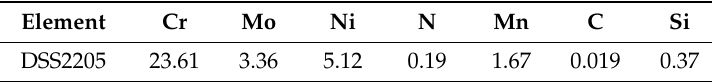
Table 1. Composition of the experimental steel,